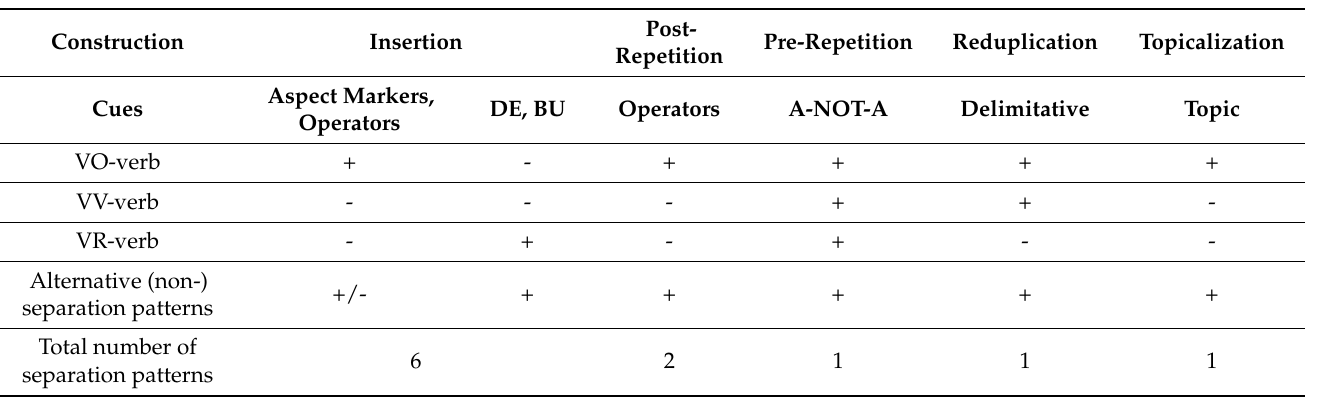
Table 1. Summary of verb